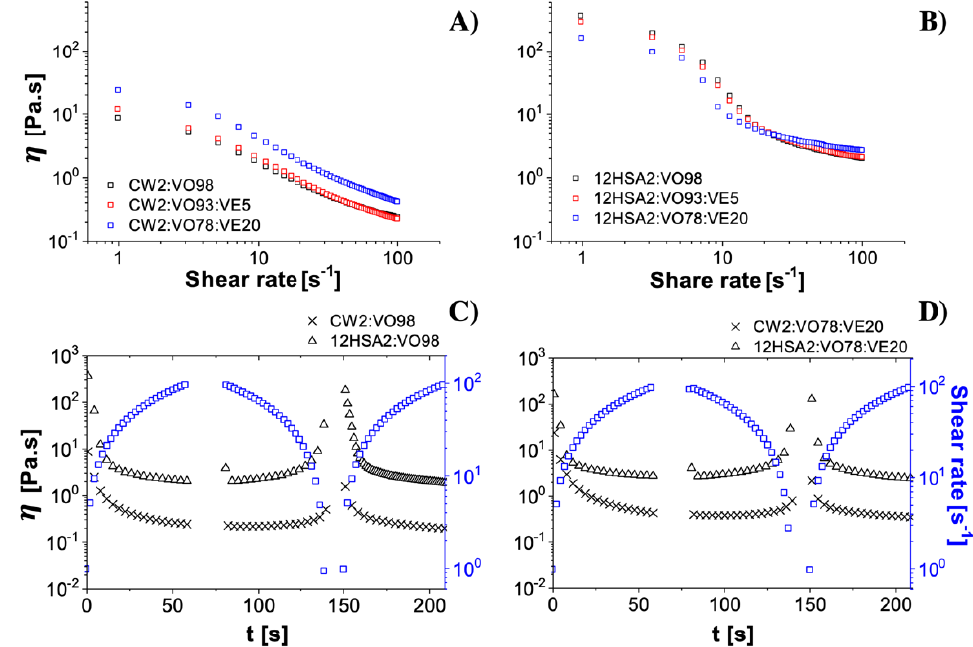
Figure 3. Viscosity (η) versus shear rate for CW organogels ( A ) and for 12HSA organogels ( B ). Structure recovery after shear stress (black dots) for the organogels without VE ( C ) and with VE ( D ). Table 1. Fitting parameters of the Carreau – Yasuda equation for flow curves and approximate phase transition temperatures Tmelt (melting temperature) and Tgel (gelation temperature).